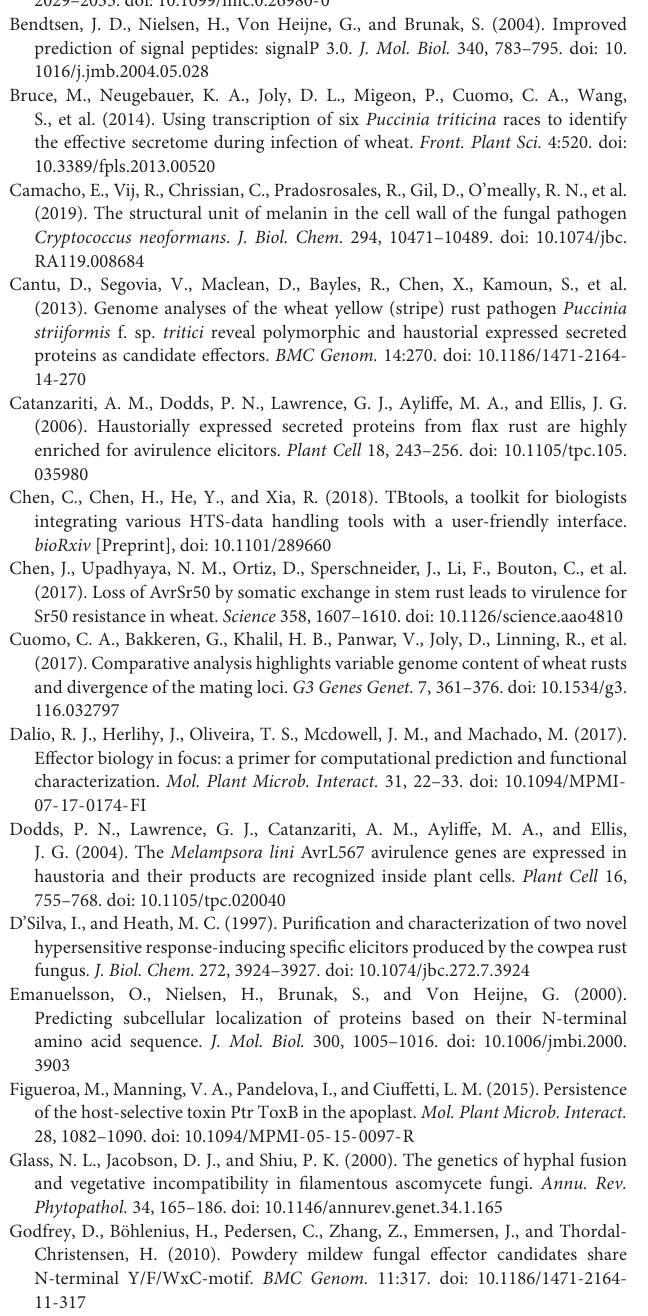
TABLE S1 | Primers used in the HR suppression assays. TABLE S2 | Primers used in the qRT-PCR